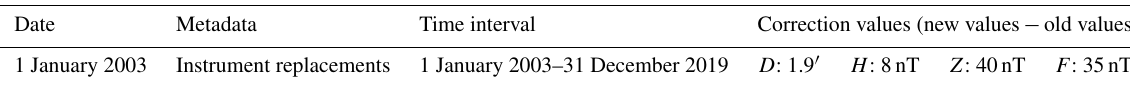
Figure 10. The contrast curve of SSH, COM, WHN, and GZH from 15 to 24 October 2013. Table 2. Date and the reasons recorded of the data to be